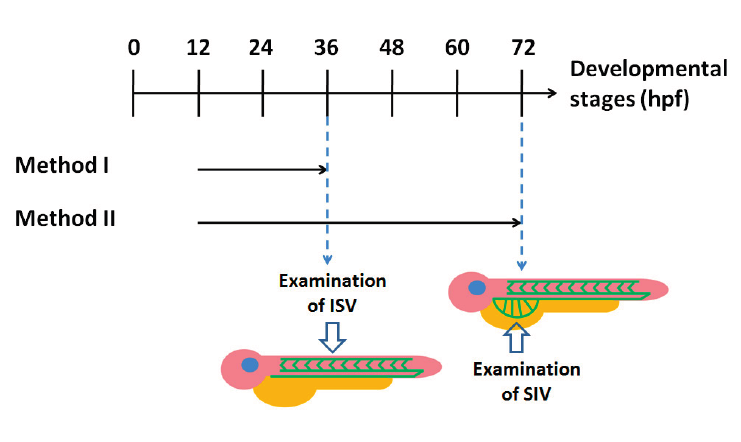
Figure 2. Exposure methods used in this study. Zebrafish wild type or Tg( fli1:egfp )